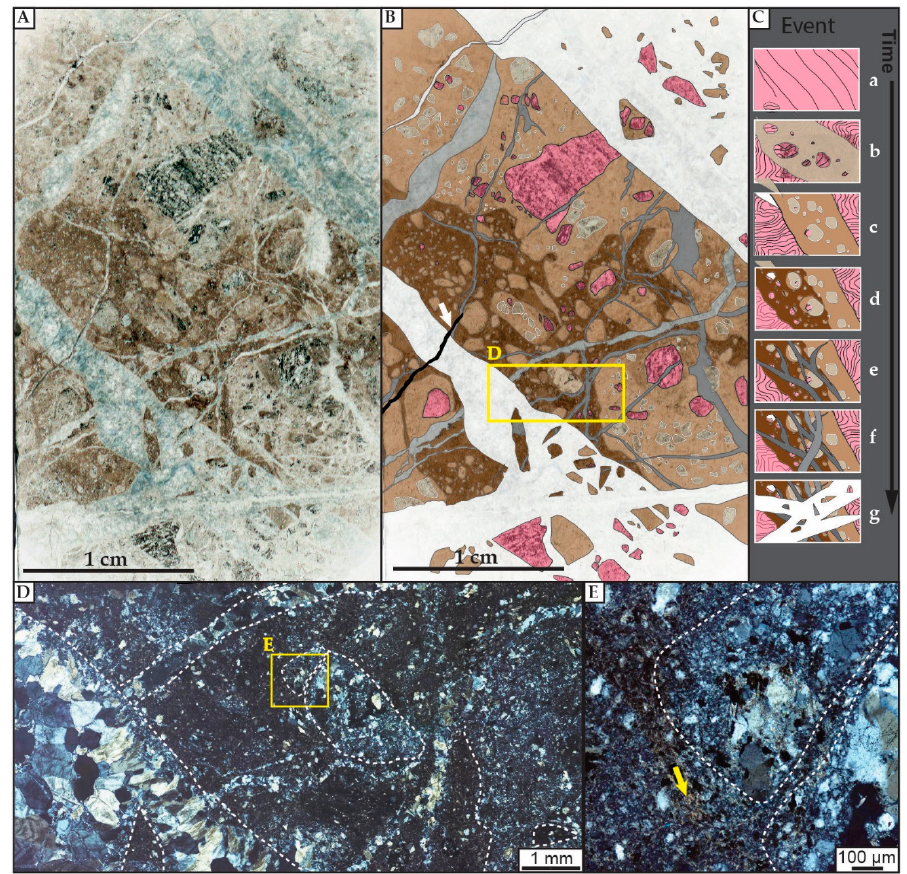
Figure 5. ( A , B ) Thin section of a polyphase cataclastic fault rock crosscut by several generations of quartz veins of the QB. White arrow indicates a late microcrystalline quartz veinlet; ( C ) simplified chronology of the events; ( D ) zoom on the different generations of clasts; and ( E ) matrix of the latest cataclastic event displaying white micas and micro-crystalline quartz.